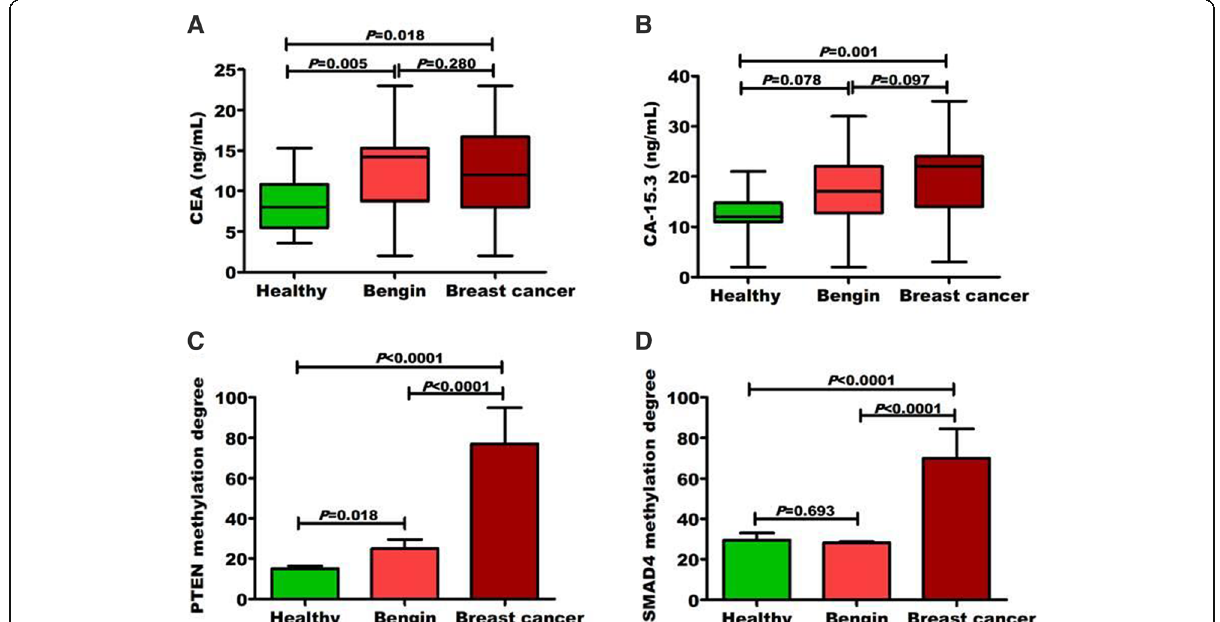
Fig. 1 The distribution of investigated markers among the investigated groups. a Level of CEA, ( b ) level of CA 15.3, ( c ) level of PTEN, and ( d ) level of